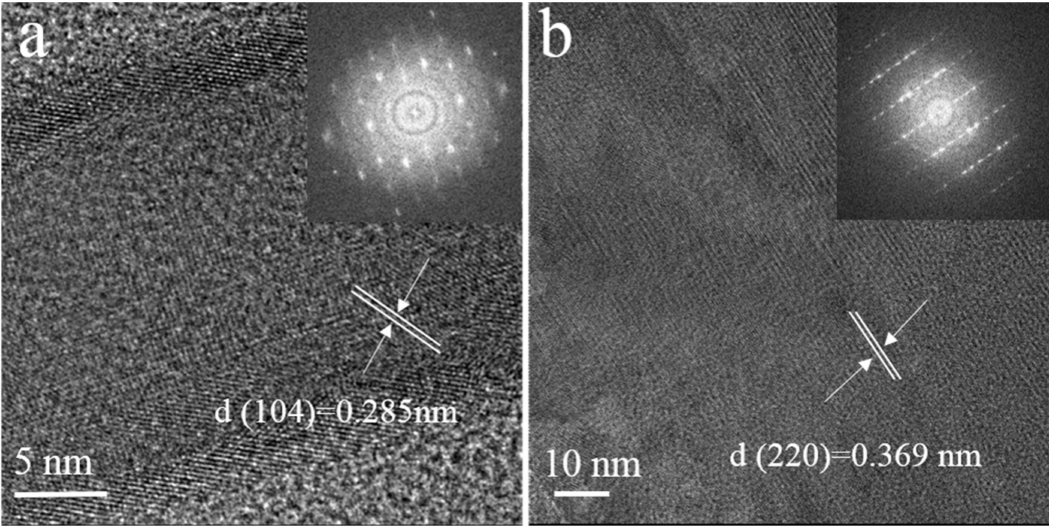
Figure 5. High-resolution transmission electron microscopy (HRTEM) and fast Fourier transform (FFT) images (inset) of new precipitates from ( a ) Mn-10 and ( b ) Cu-10 after dissolution for 2880